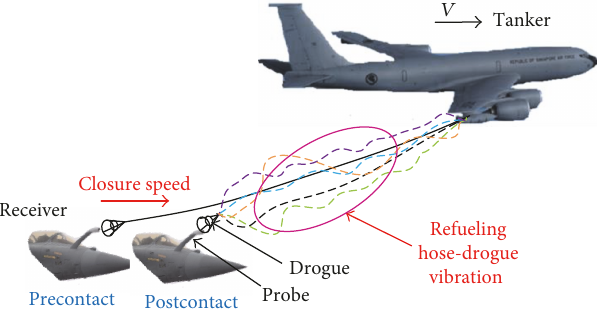
Figure 1: The refueling hose-drogue assembly vibration due to excessive closure